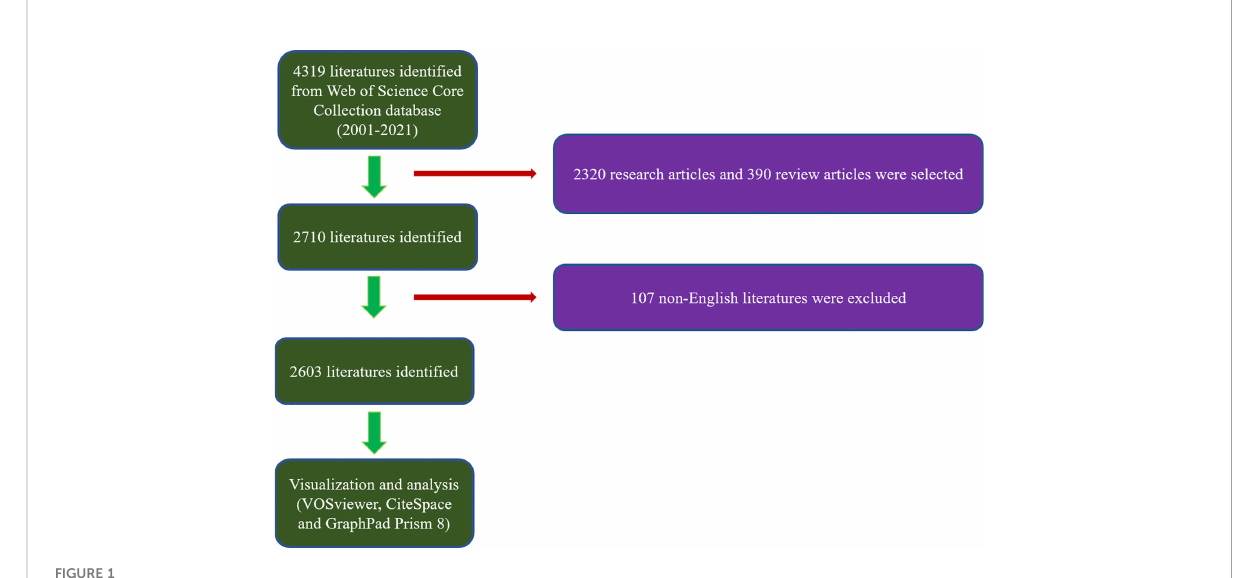
FIGURE 1 Flow diagram of the study identi fi cation and inclusion